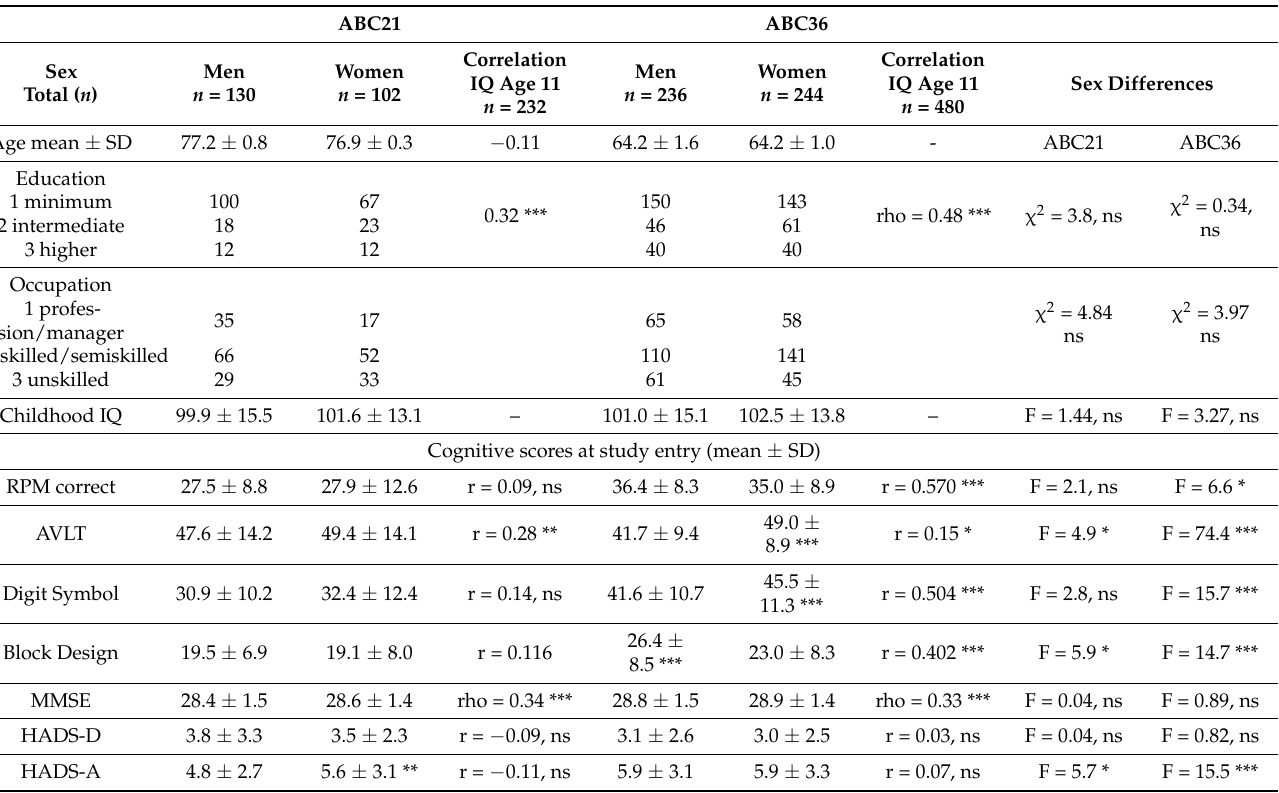
Table 1. Sociodemographic characteristics, cognitive test scores and HADS-Anxiety (A) and HADS- Depression self-rating scale scores for the Aberdeen 1921 (ABC21) and 1936 (ABC36) birth